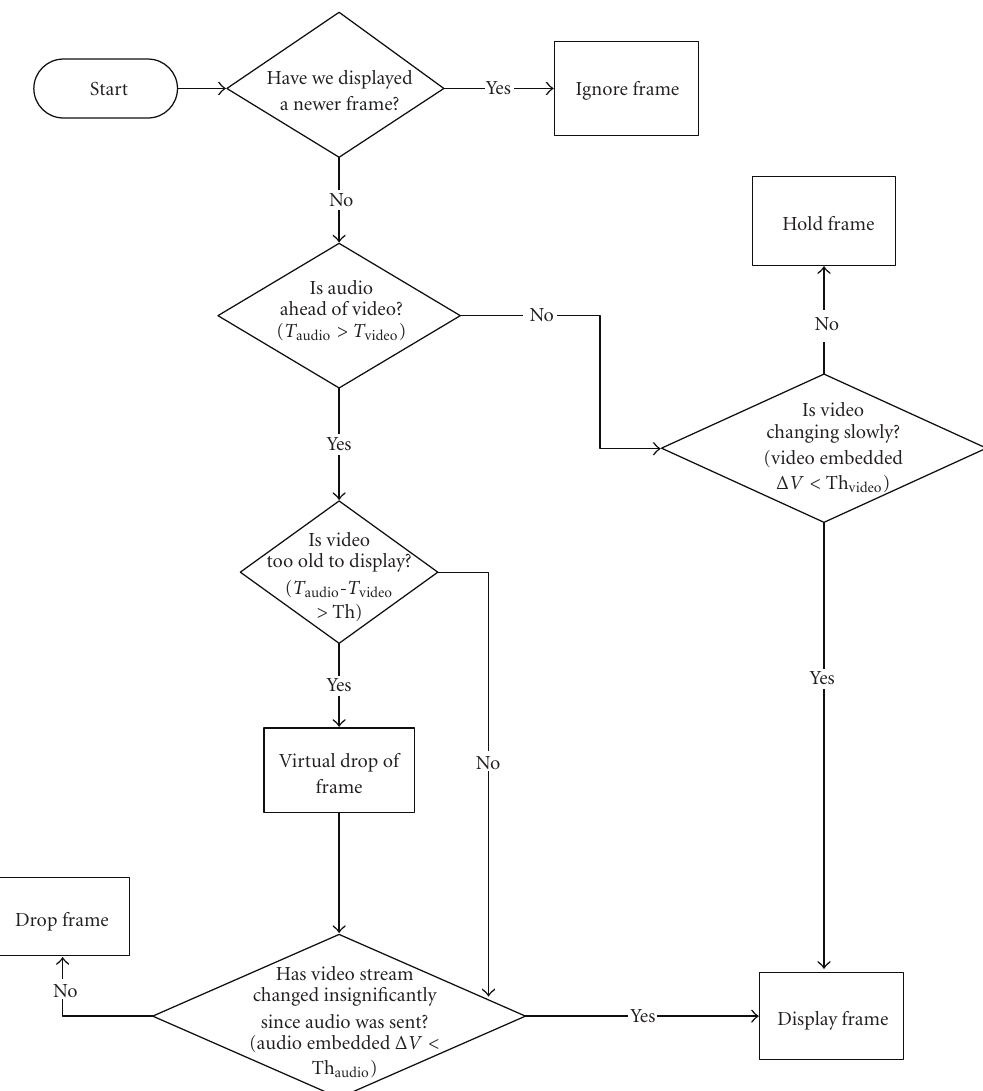
Figure 3: Flow chart of content-based synchronization algorithm for video conferencing